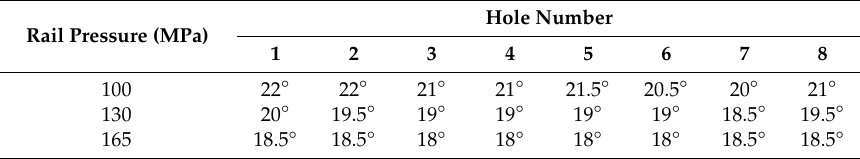
Table 2. The cone angle of the fuel sprays of nozzle 1.